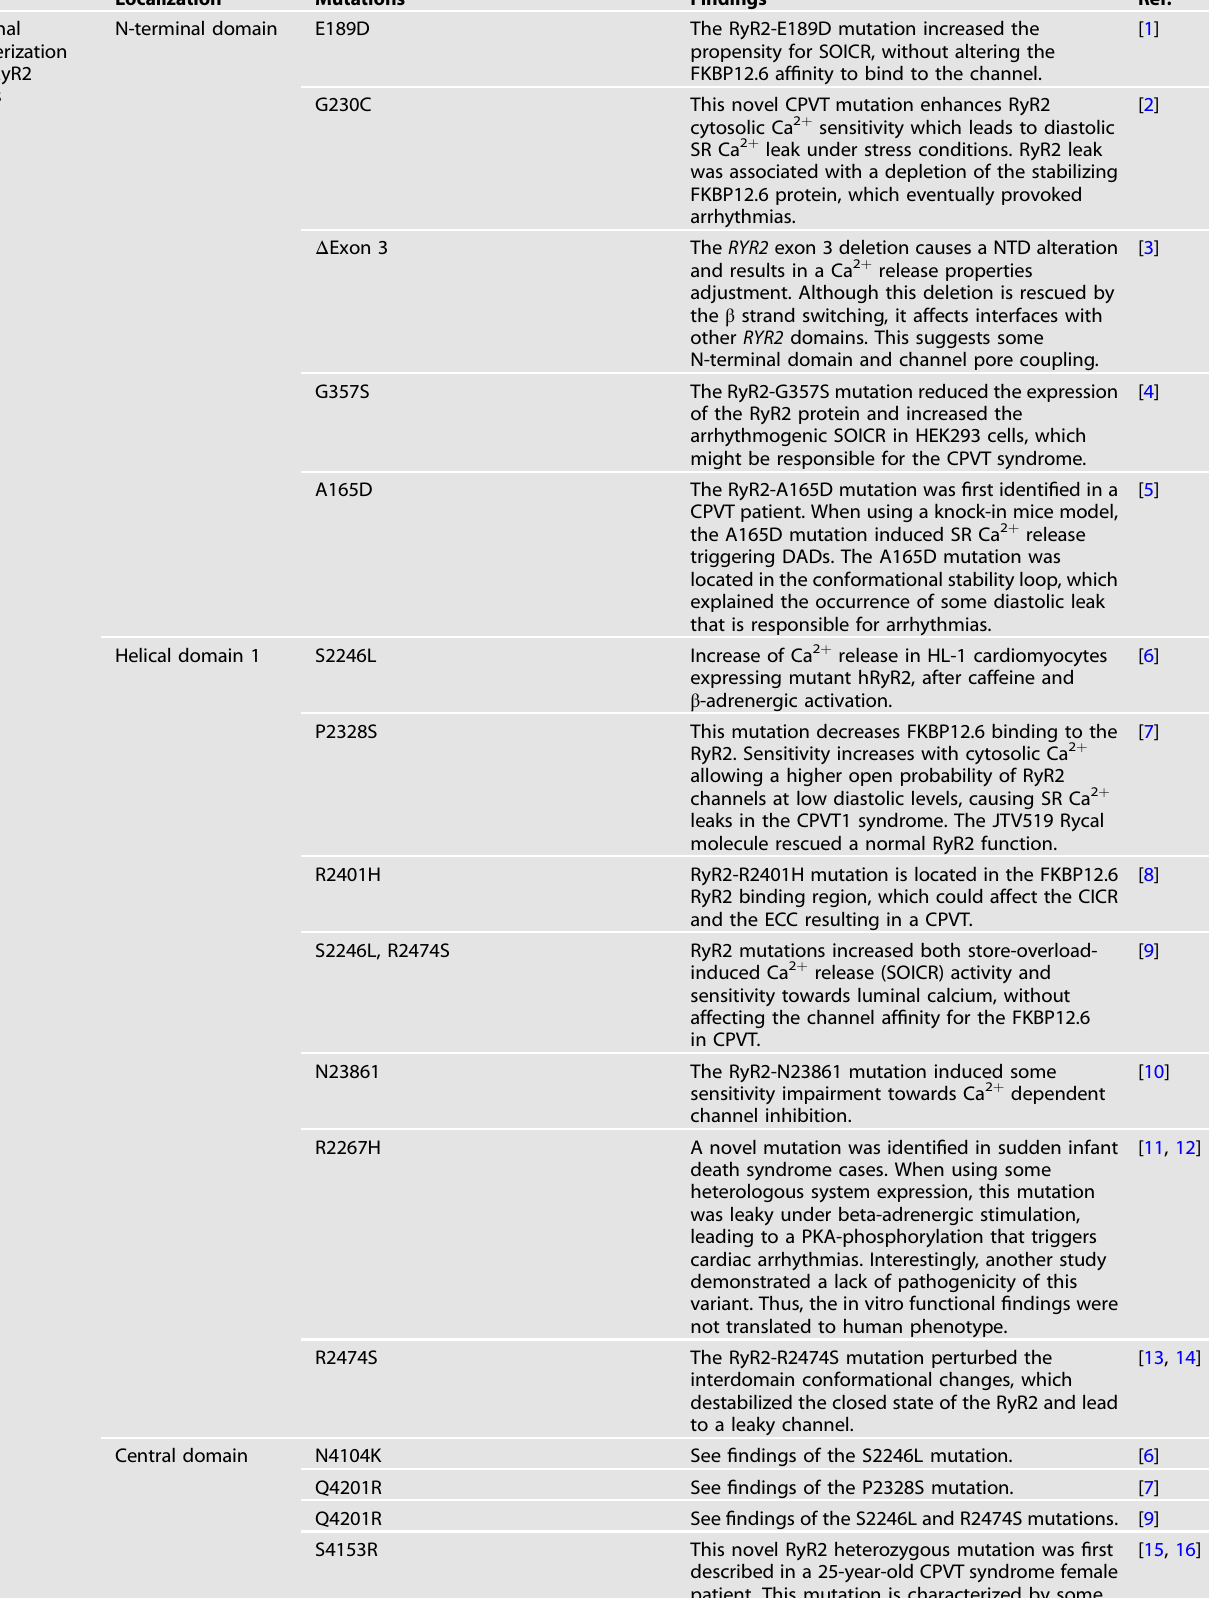
Table 1. List of the RyR2 mutations associated with the CPVT